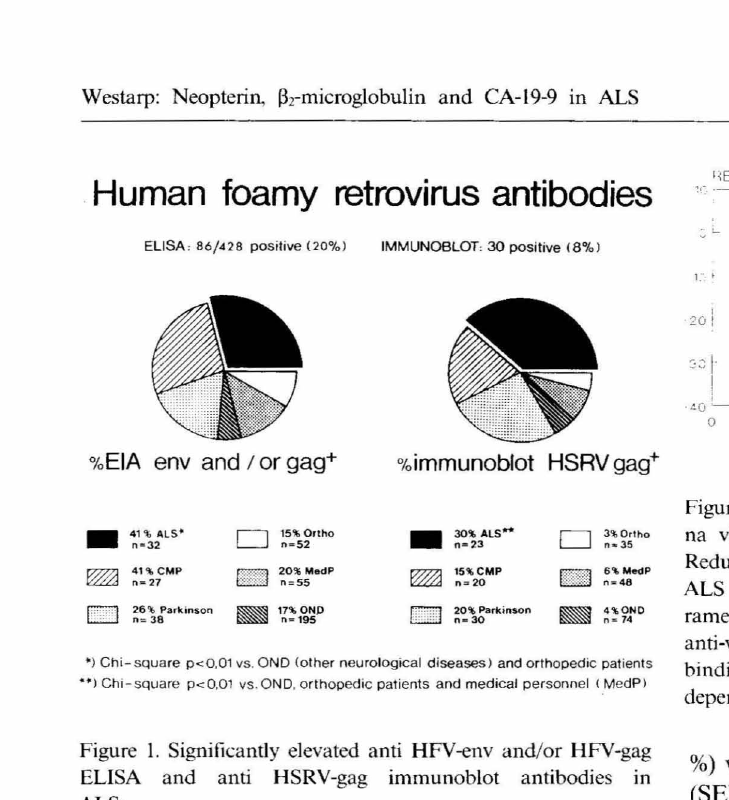
Figure 2. Competition by ALS sera with polyc1onal maedi-vis na virus antibodies (blocking ELISA): Reduction in optical density (ELISA) by pre-incubation with ALS sera (in %, standardized to healthy controls = 0%) as pa rameter for competition of ALS sera with specific polyclonal anti-visna antibodies. 47/50 sera of 28/30 ALS patients reduce binding of secondary anti-visna antibody. Competition is in dependent from age at onset or variant of the disease. %) was 89.0%± 1.9 (SE) for ALS sera and 93.1%±